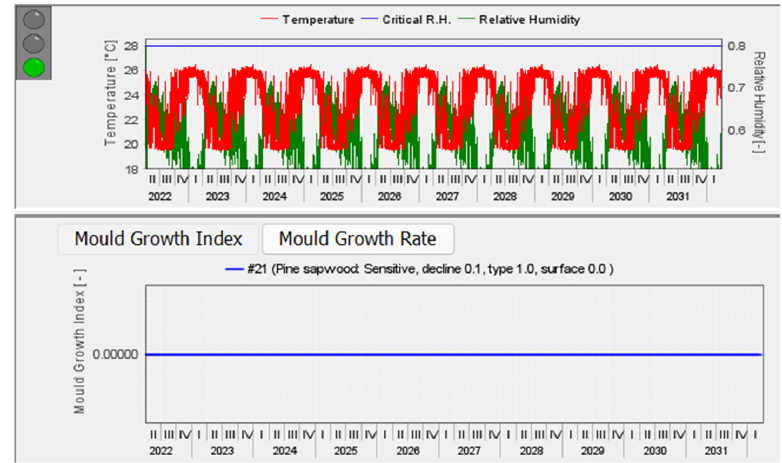
Figure 18. Typical mould growth index graph for Australia’s temperate climate using EPW climate file.